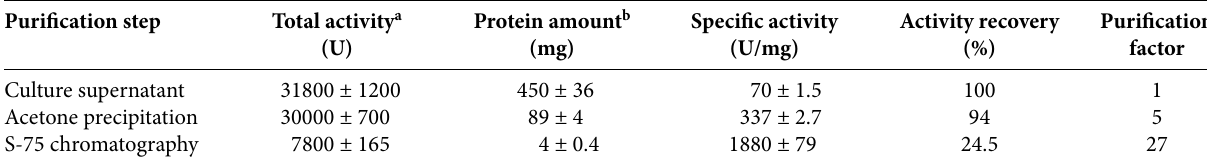
Table 6. Flow sheet of the AKL29 partial purification.